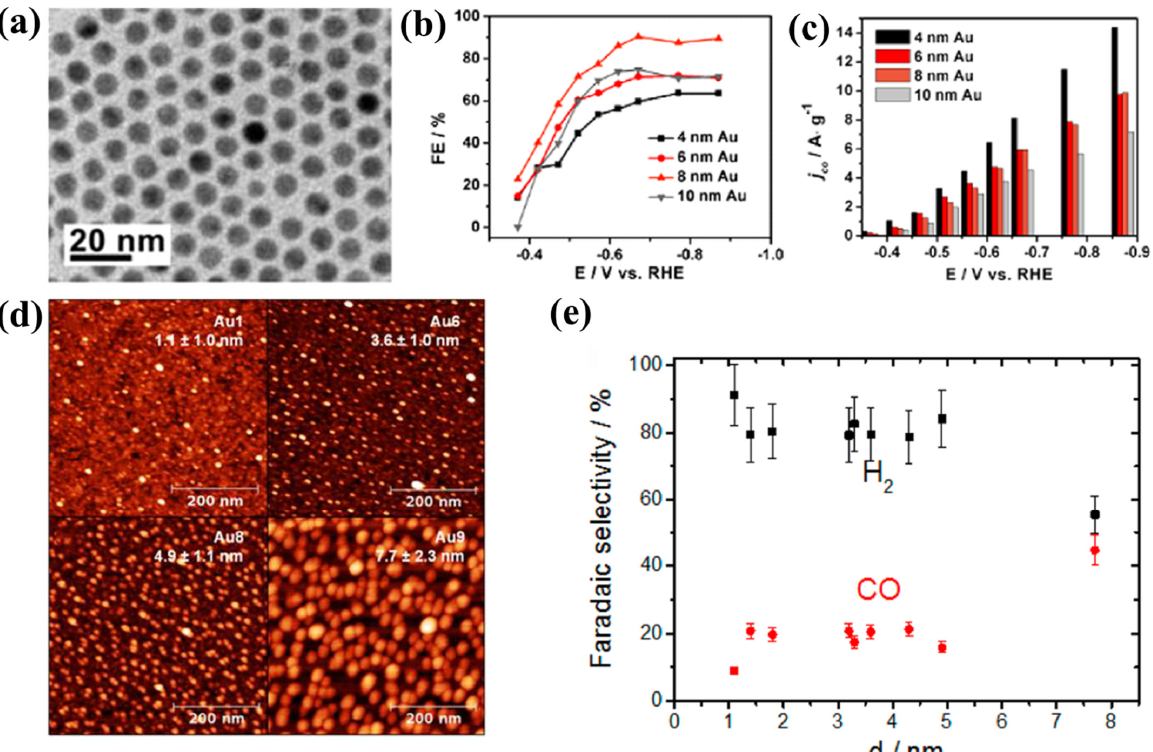
Figure 6. ( a ) TEM images of 8 nm Au NPs. ( b , c ) Potential-dependent FEs and mass activity of four different sizes of monodisperse Au nanoparticles on electrocatalytic CO 2 reduction. Reproduced with permission from Ref. [92]. Copyright 2013, American Chemical Society. ( d ) AFM images of four different size Au NPs samples prepared by inverse micelle encapsulation and supported on SiO 2 /Si (111). ( e ) Faradaic efficiency toward H 2 and CO as a function of NP size. Data were acquired in 0.1 M KHCO 3 at E = − 1.2 V vs. RHE. Reproduced with permission from Ref. [93]. Copyright 2014,